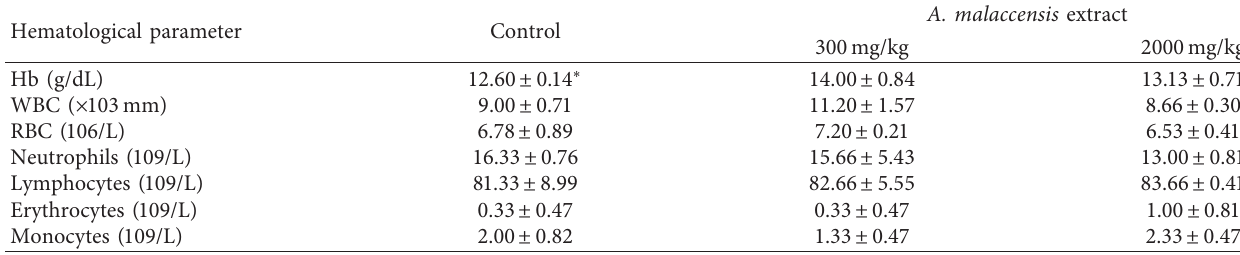
Table 3: Serum hematological values of female rats.